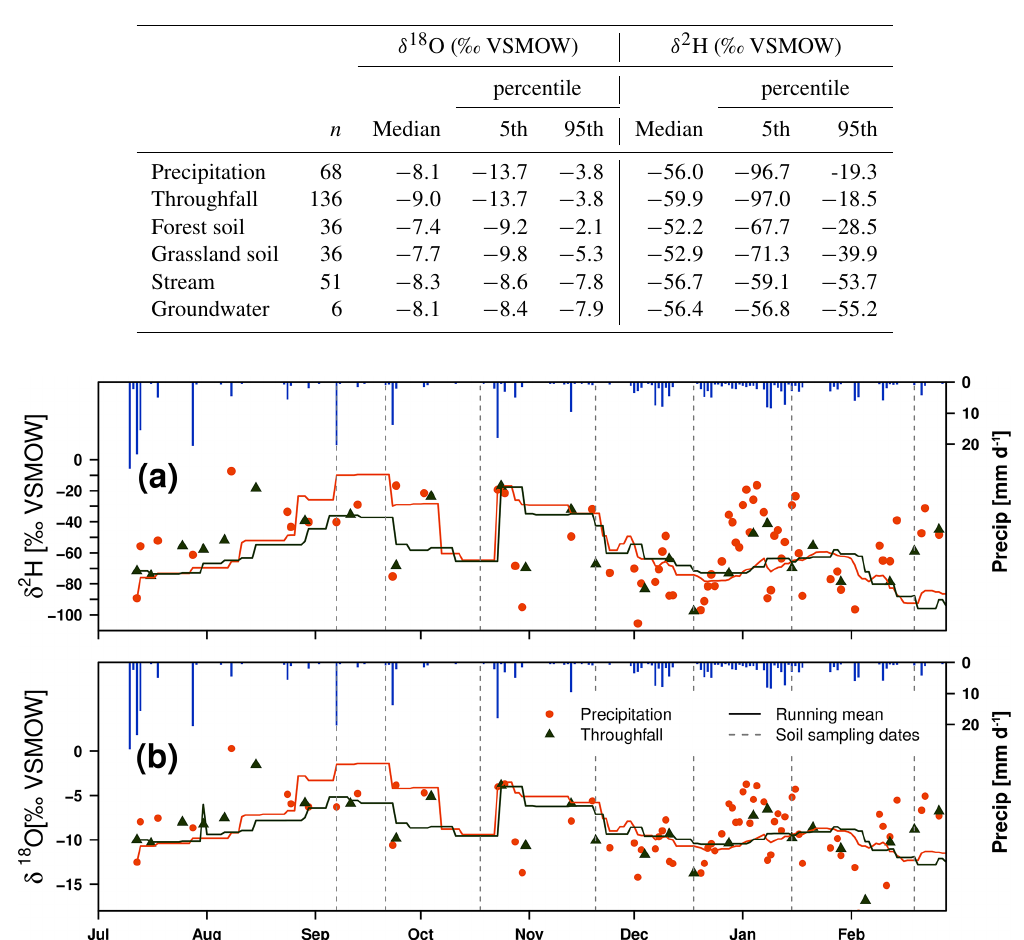
Table 4. The number ( n ) and 50th (median), 5th, and 95th percentiles of δ 18 O and δ 2 H (‰ VSMOW) signatures of the sampled water cycle compartments.